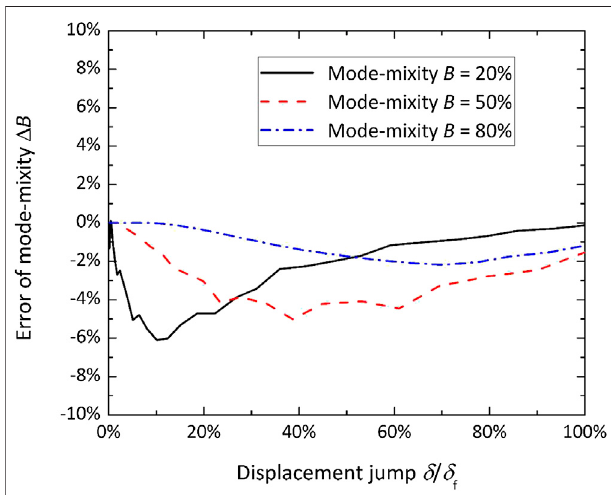
FIGURE8| Errorofmodemixityfromtheassumption ofsmallchangeof mode mixity.